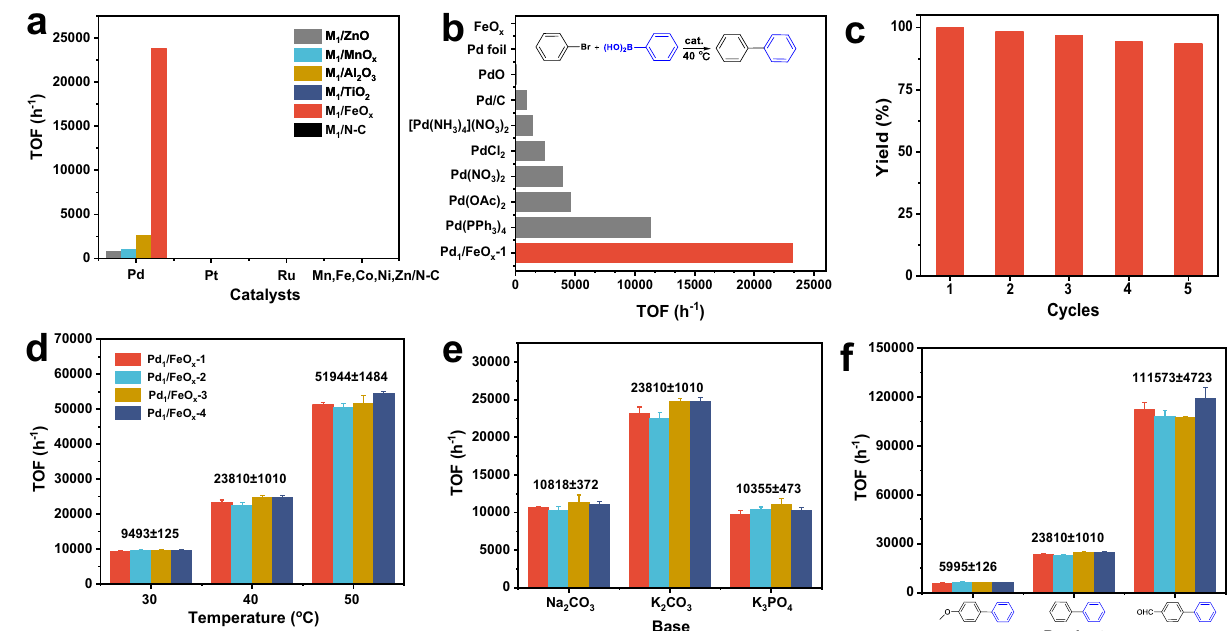
identicalas a ,exceptforthetemperatures. e CatalyticperformanceofPd 1 /FeO x -1,2, 3, 4 with different bases. Reaction conditions were identical as a , except for the bases. f Catalytic performance of Pd 1 /FeO x -1, 2, 3, 4 for the formation of different products. Reaction conditions were identical as a , except for the substrates: 0.5mmol (4-bromoanisole, bromobenzene or 4-bromobenzaldehyde) and 0.75mmolphenylboronicacid,respectively.The errorbarsrepresentthe standard deviation based on triplicate